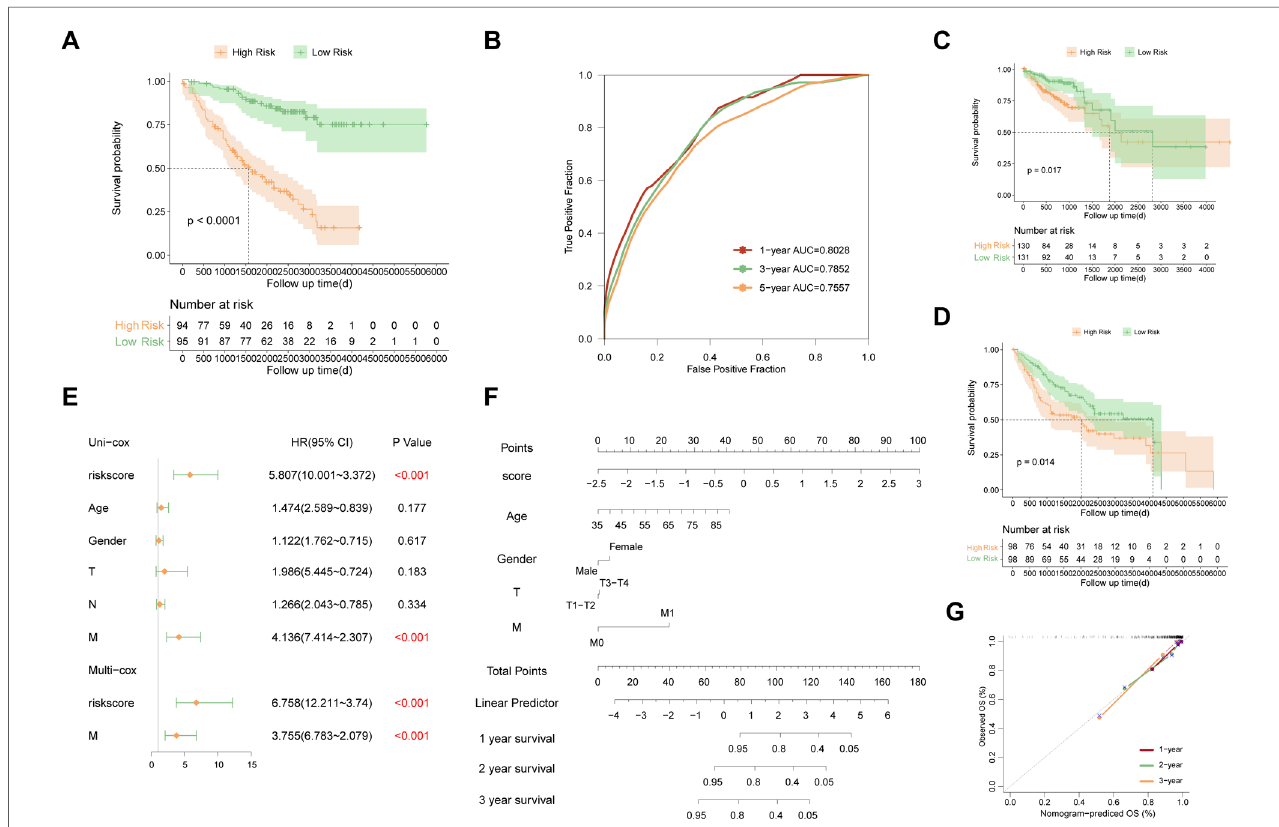
FIGURE 3 Evaluation and validation of the established signature in TP53 mutant COAD. ( A ) Kaplan – Meier survival curve between high risk and low risk groups in TP53 mutant samples of GSE39582. ( B ) Time-dependent ROC curve in TP53 mutant samples of GSE39582. ( C ) Kaplan – Meier survival curve between high risk and low risk groups in TP53 mutant samples of combined RNA-seq cohort. ( D ) Kaplan – Meier survival curve between high risk and low risk groups in estimated TP53 mutant samples of combined GEO cohort. ( E ) Multivariate analysis in TP53 mutant samples of GSE39582. ( F ) Nomogram based on the established signature in TP53 mutant samples of GSE39582. ( G ) Calibration curve of 1-year to 3-year survival predictive ef fi ciency of the